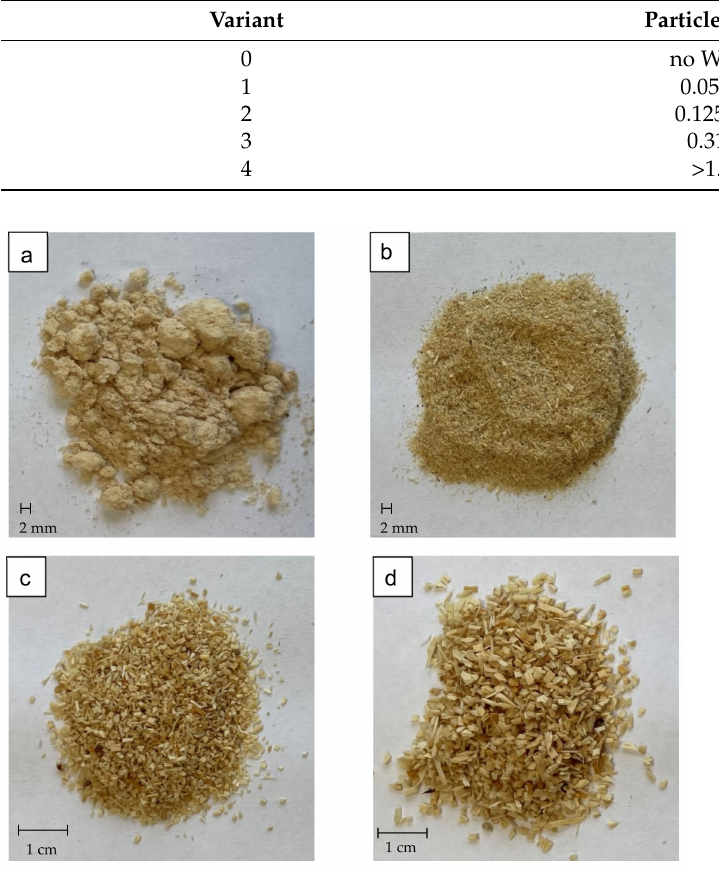
Figure 1. Wood particles used as a filler: ( a ) 0.05–<0.125 mm; ( b ) 0.125–<0.315 mm; ( c ) 0.315–1.25 mm; ( d ) >1.25–2.0